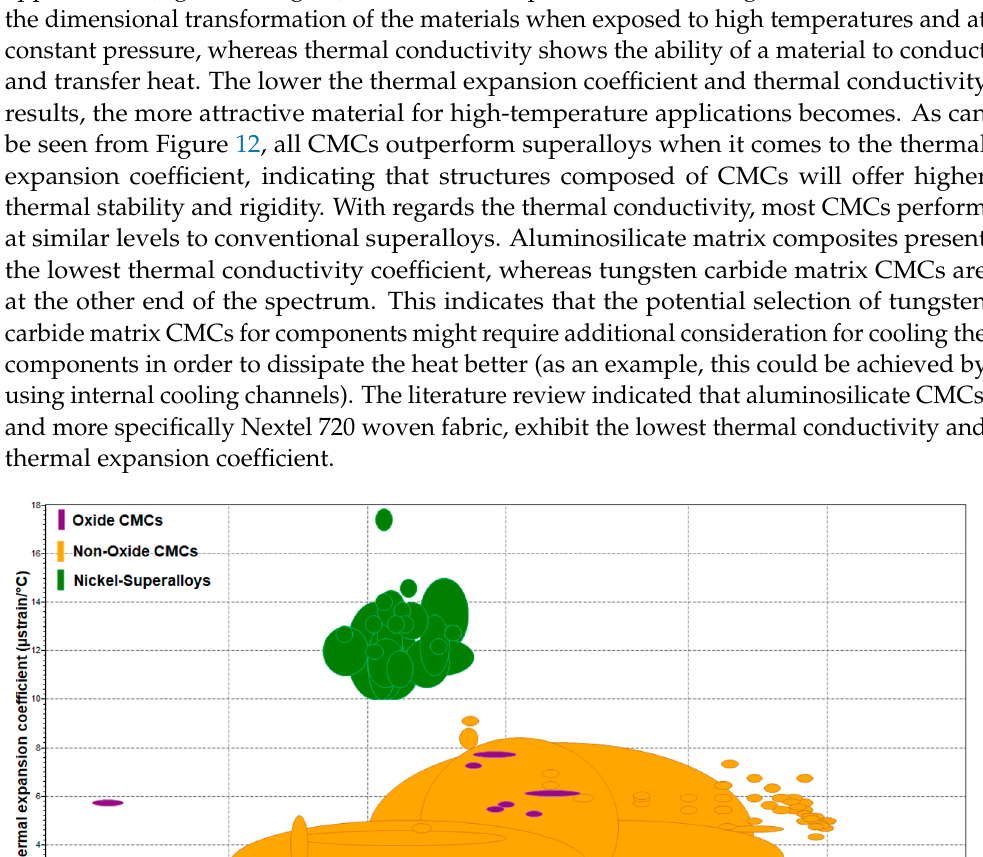
Figure 10. ( Left ) Fatigue strength at 10 7 cycles and ( right ) fracture toughness of the available CMCs and comparison with superalloys.